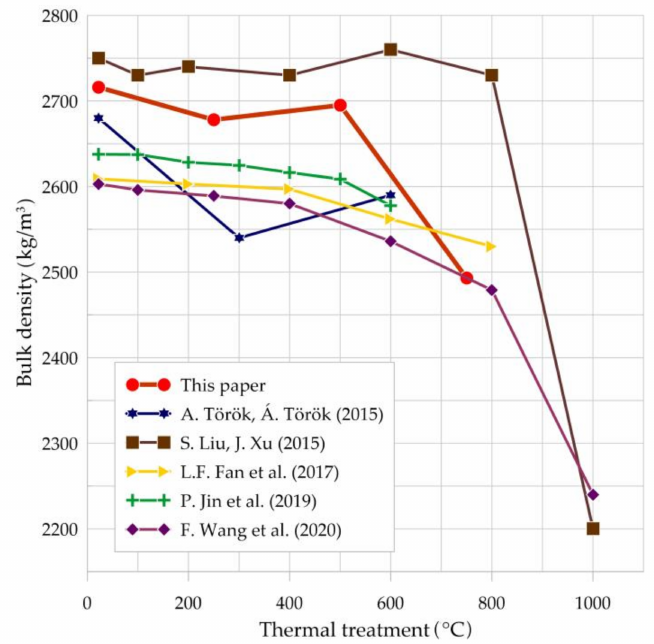
Figure 9. Scatter plot of bulk density values of heat-treated granite samples of this paper compared to previous